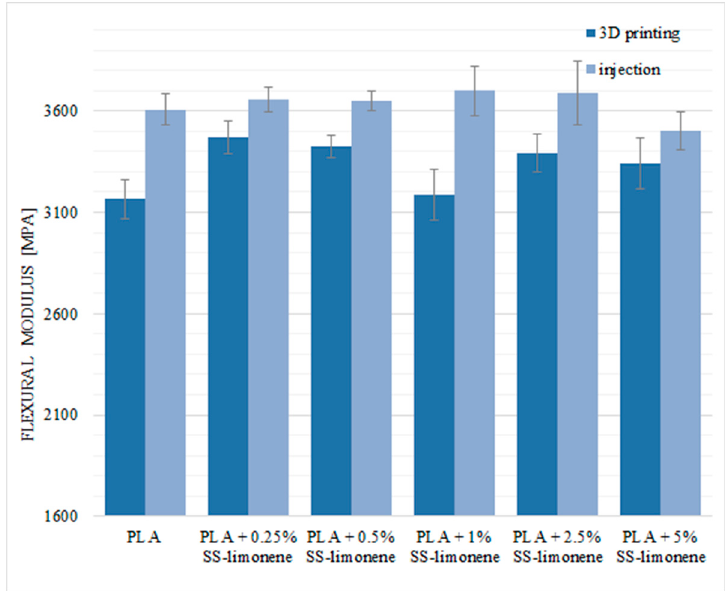
Figure 11. Flexural modulus of SS-Limonene/PLA in 3D printing and injection moulding.